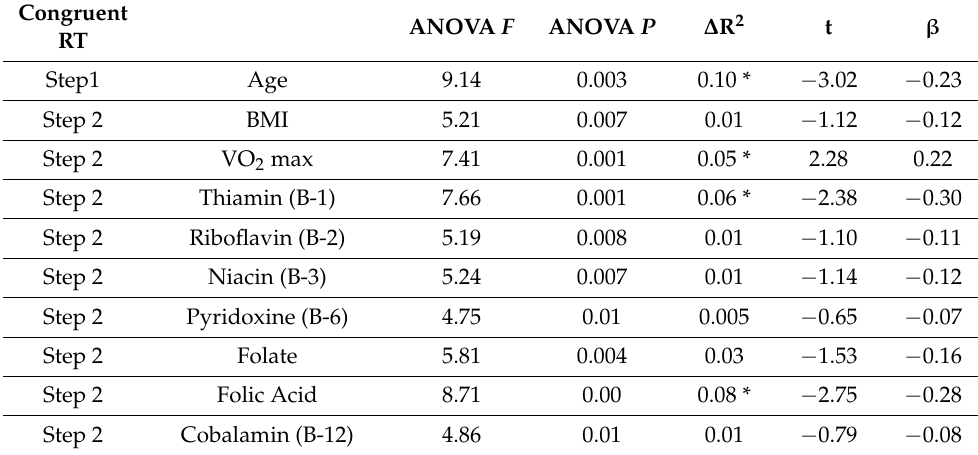
Table 5. Congruent Reaction Time